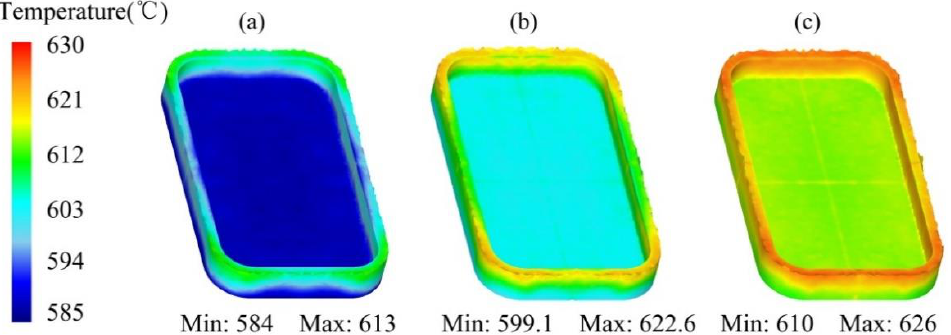
Figure 14. Temperature distribution of the mobile phone shell processed by the thixotropic extru- sion at the extrusion speed of ( a ) 5 mm/s, ( b ) 10 mm/s, and ( c ) 15 mm/s. at the extrusion speed of ( a ) 5 mm/s, ( b ) 10 mm/s, and ( c ) 15